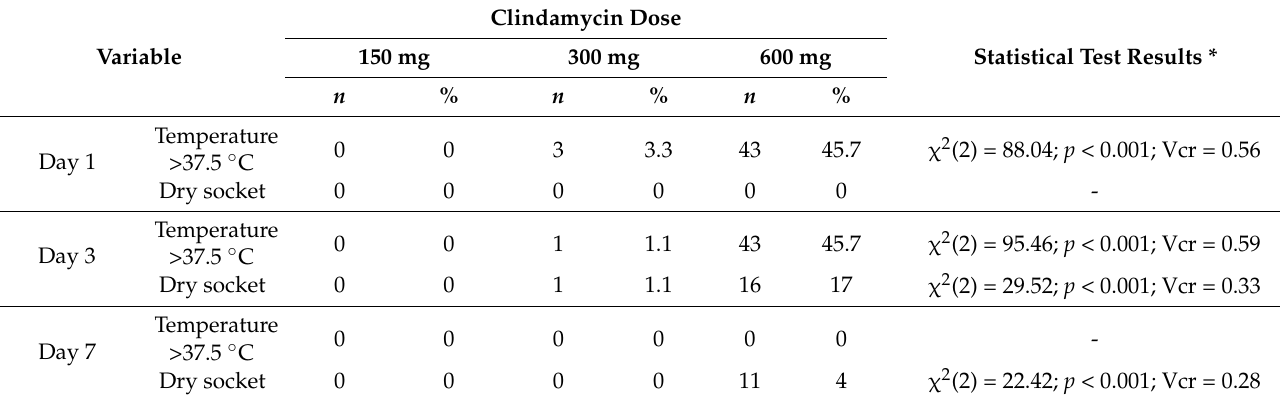
Table 6. Occurrence of elevated temperature and local